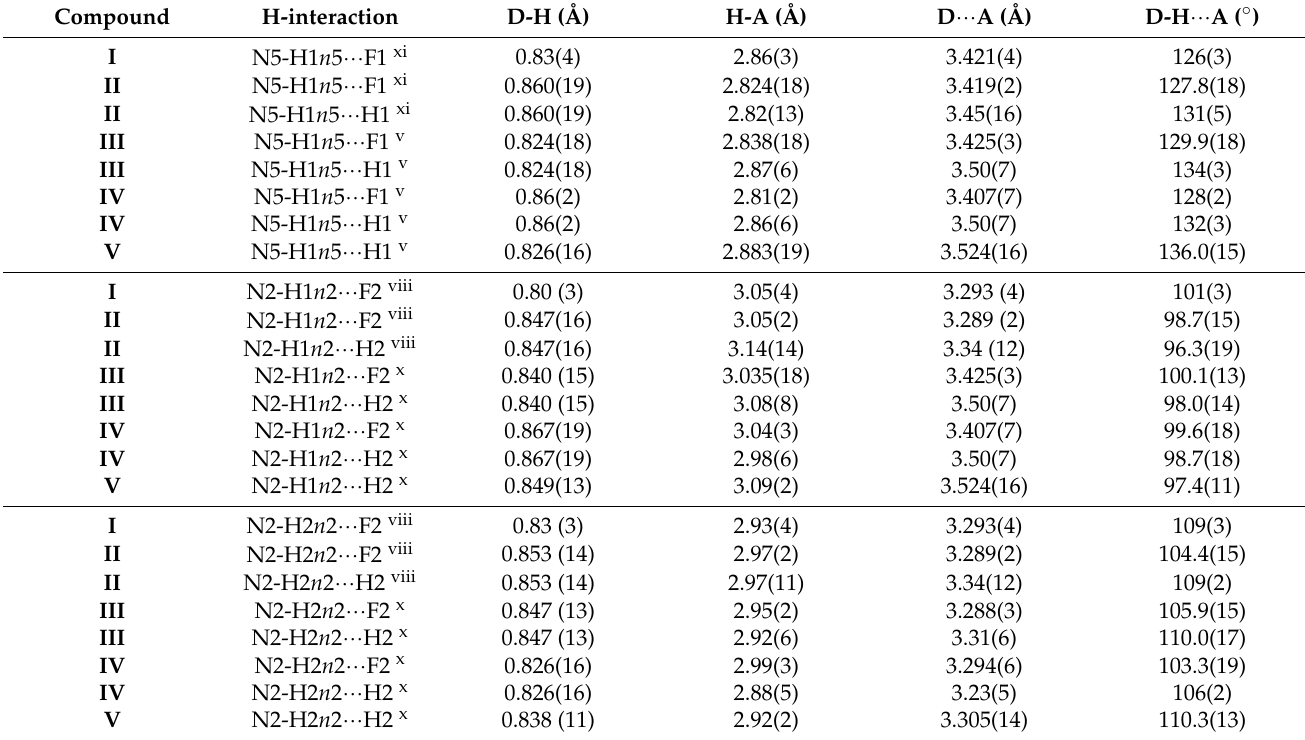
Table 4. The closest intermolecular interactions to anionic F and H hydrido hydrogen in the title structures for compounds ( I )–( V